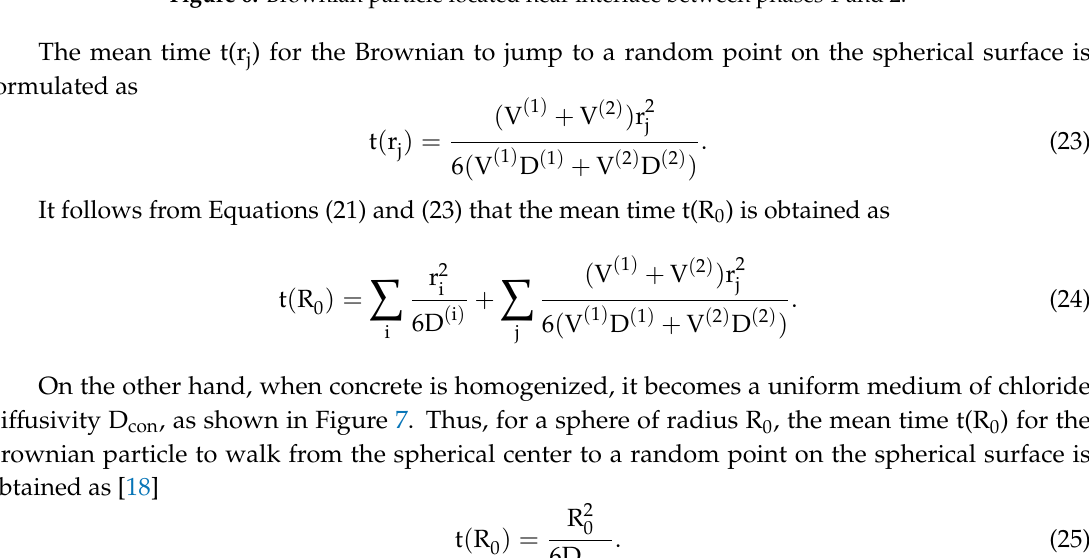
Figure 6. Brownian particle located near interface between phases 1 and 2.